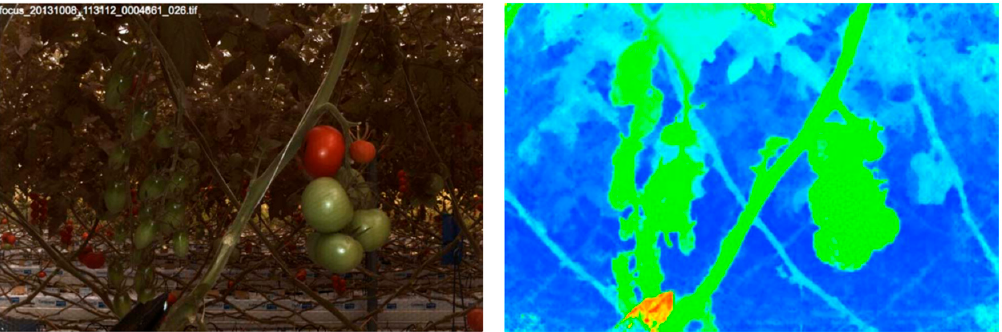
Figure 5. RGB ( left ) and depth image ( right ) using a light field camera (reproduced from Polder and Hofstee [103]).